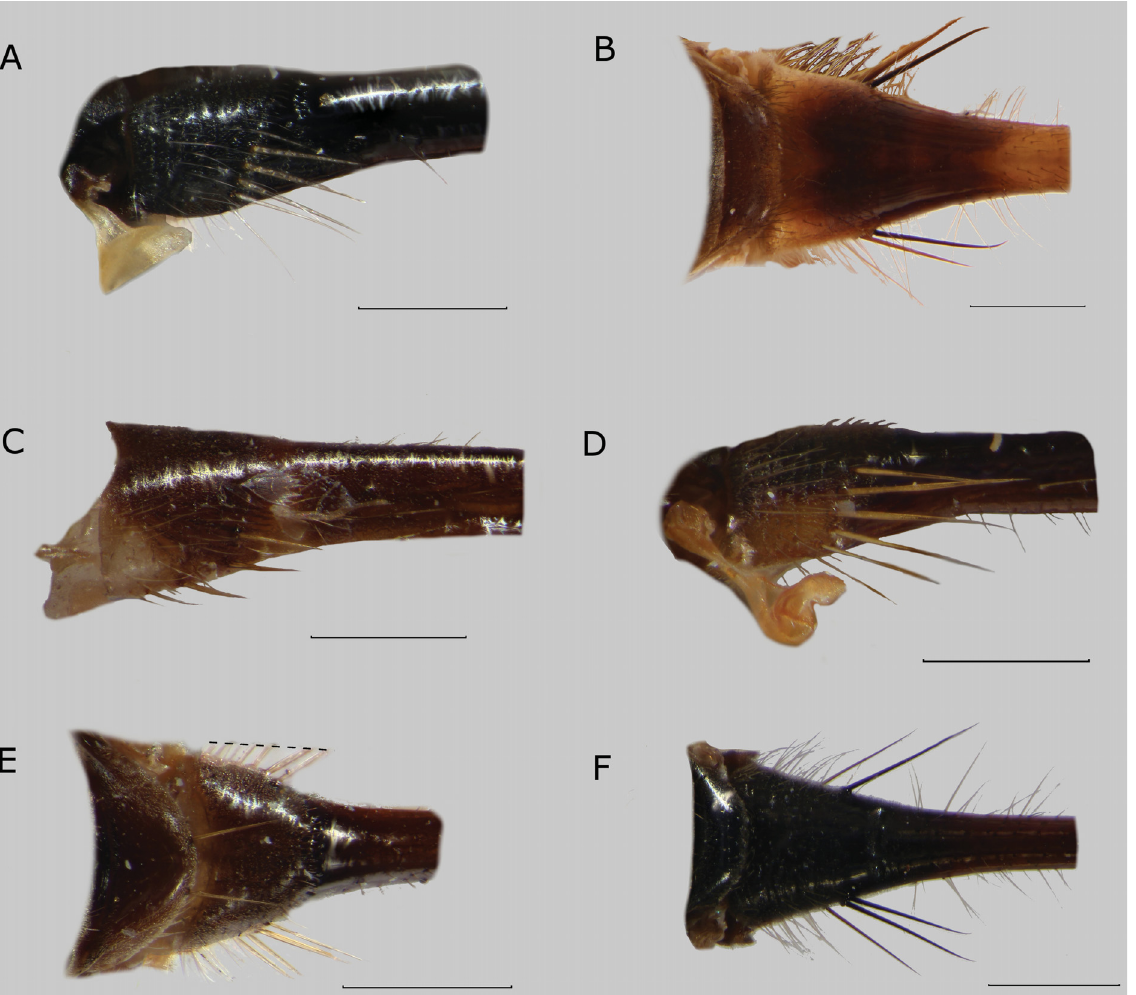
Fig. 47. Tergum I, lateral view (A, C–D) and dorsal view (B, E–F). A . Sphegina (Asiosphegina) dentata sp. nov., paratype, ♂ , Taiwan. B . S. (A.) distincta sp. nov., par atype, ♂ , Vietnam. C . S. (A.) falcata Hippa, van Steenis & Mutin, 2015, holotype, ♂ , Myanmar. D . S. (A.) farinosa sp. nov., holotype, ♂ , Sabah, Malaysia. E . S. (A.) javana de Meijere, 1914, Paralectotype ♂ , Java, Indonesia. F . S. ( A. ) lobulata sp. nov., paratype, ♂ , Vietnam. Dotted line indicates unknown length of right sided setae, the right metaleg (erased in GIMP) obscured these setae. Scale bars = 0.5